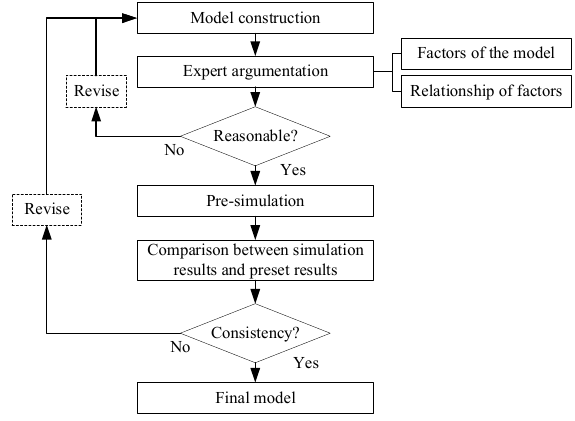
Figure 7. Process of model validation.